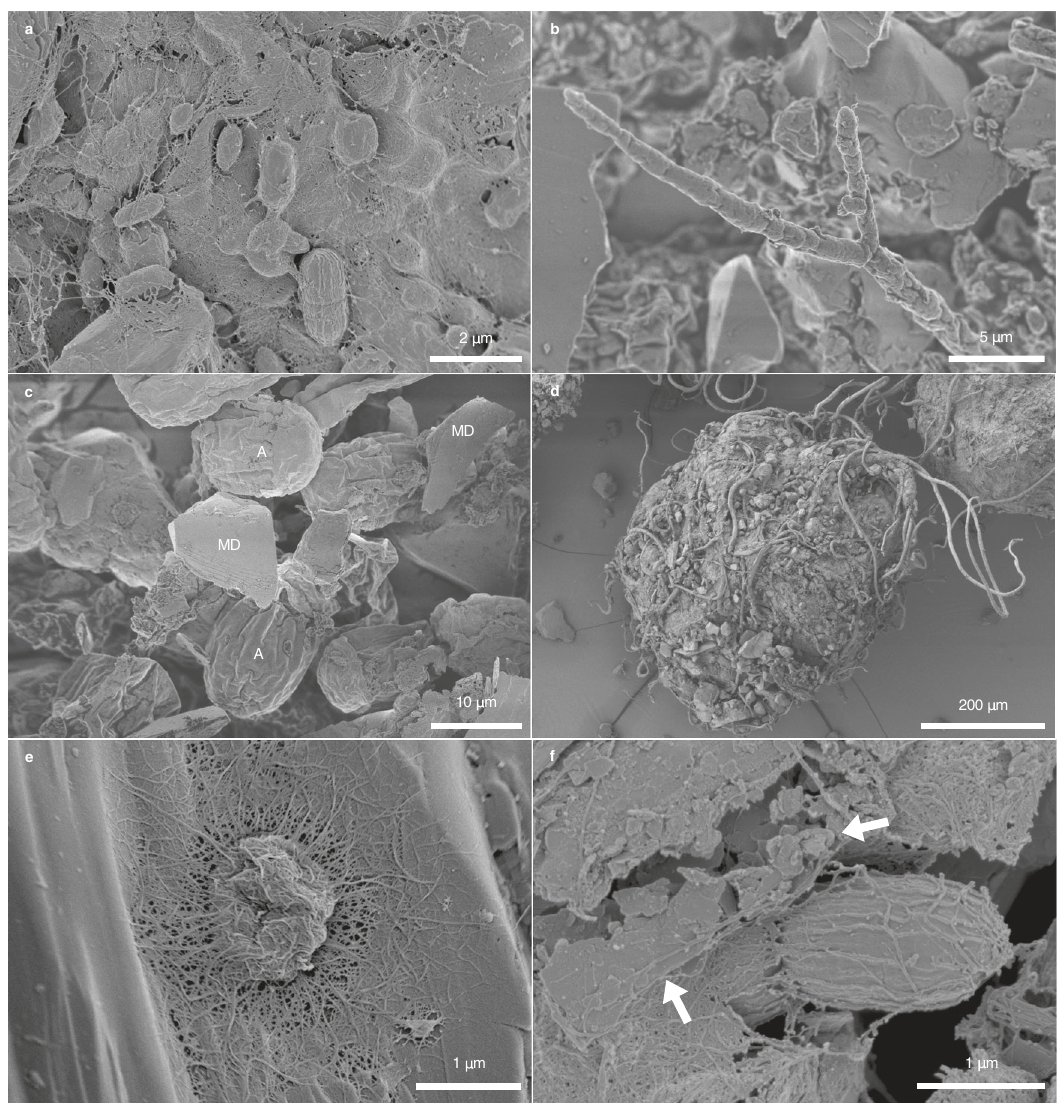
Fig. 5 Scanning electron micrographs of cell-mineral associations in Dark Zone surface habitats. Scanning electron microscopy (SEM) micrographs showing a bacteria, b fungi, and c glacier algae that comprise the Dark Zone microbial community. Microbes in c ) H bio ice are more disseminated than those in d cryoconite granules. In all surface ice habitats, exopolymer enables microbial cells to e adhere to mineral surfaces, and f trap and bind mineral grains (arrows). In c A: algal cells, MD: mineral dust. Images in a – f are representative of the n = 12 samples observed using